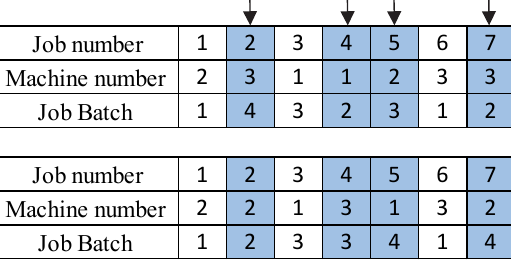
Fig. 8 The mutation